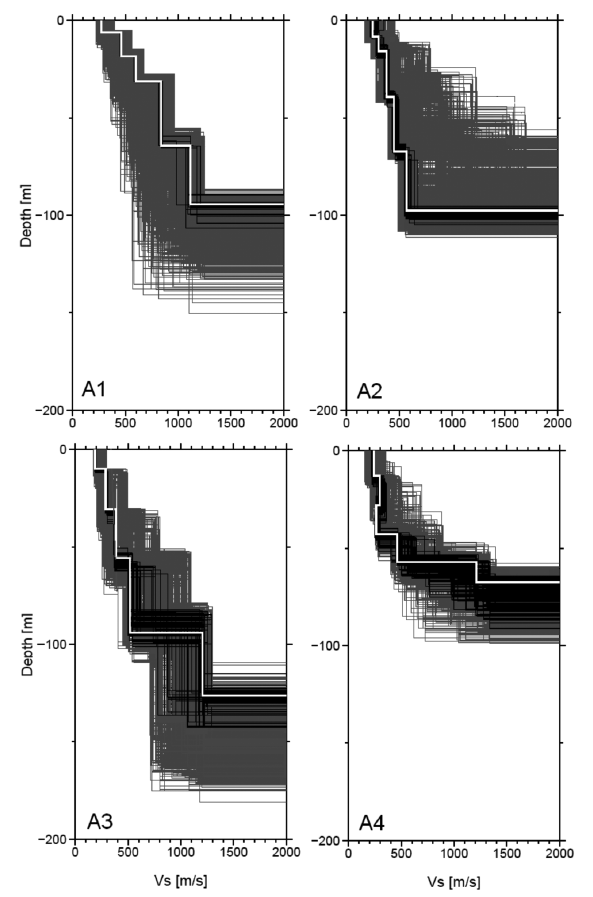
Figure 6. Shear-wave velocity profiles for array measurement sites in Dushanbe shown in Figure 5. Thin gray lines show all tested mod- els. The white line represents the minimum cost model and the black lines indicate all models lying inside the minimum cost +10%